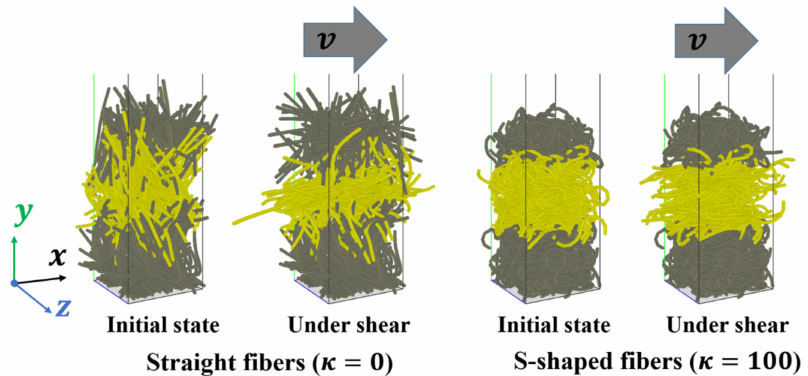
Figure 15. Numerical models of shear